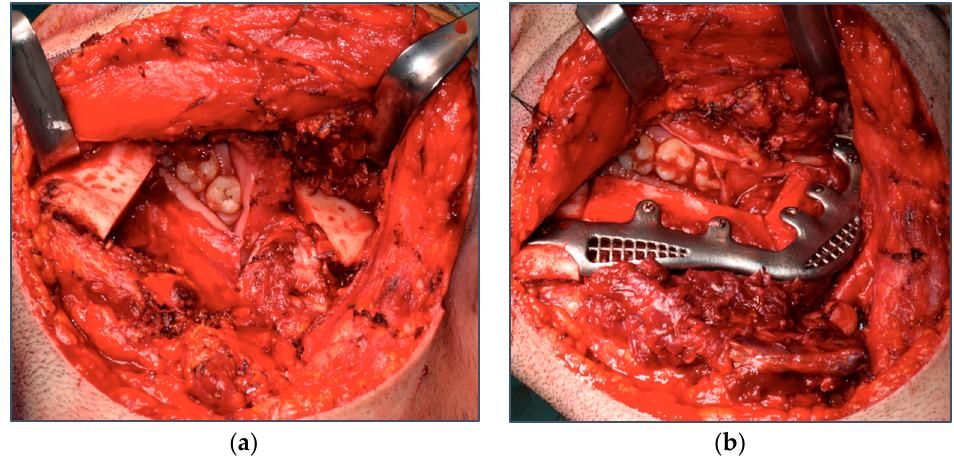
Figure 4. Intraoperative images of ( a ) a bone defect from mandibular resection and ( b ) free fibula flap on a custom-made reconstructive plate in a definitive position.